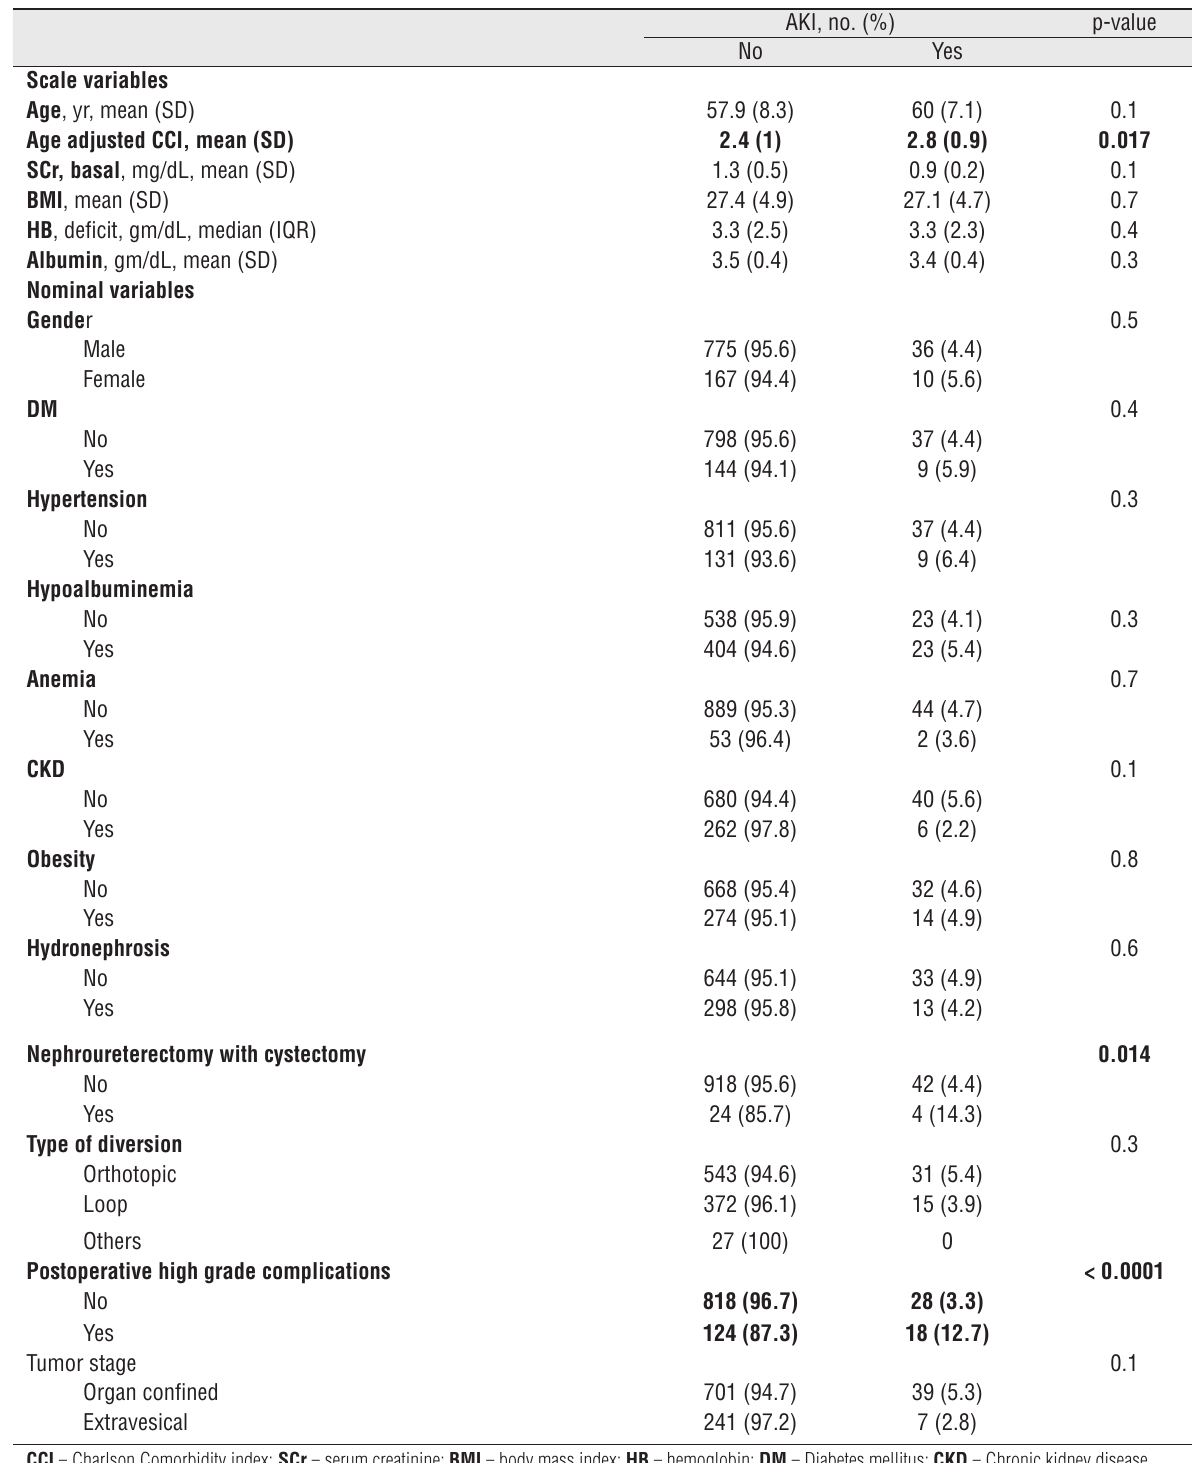
Table 2 – Demographics for patients with and without Acute Kidney Injury after Radical